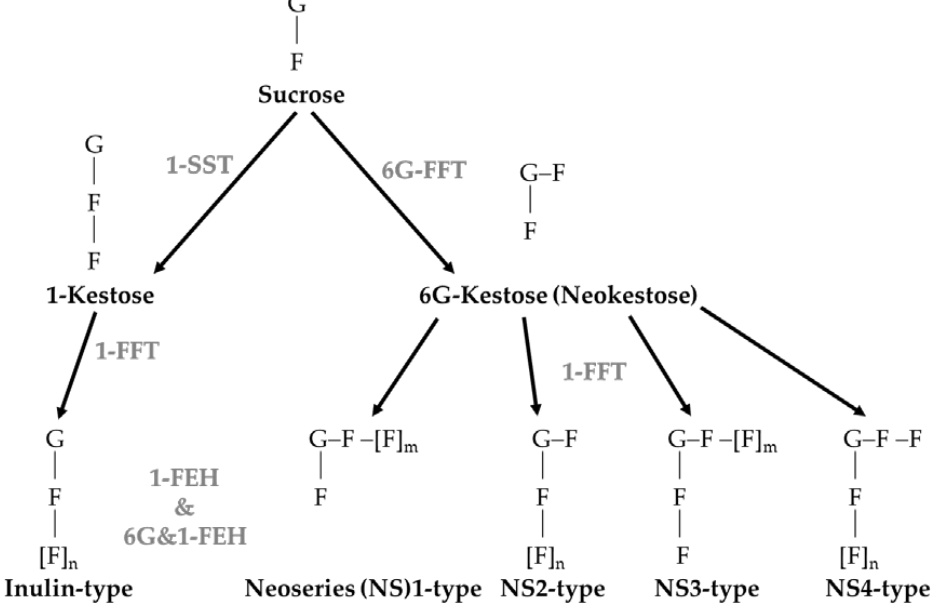
Figure 1. Oligosaccharide distribution patterns obtained by MALDI-MSI. Shown is a light microscopic image of a section together with the extracted ion intensity plots of the molecular ions [M + K] + for sucrose ( m/z 381) with a degree of polymerization (DP) of 2, as well as for oligosaccharides with DP3 ( m/z 543), DP4 ( m/z 705), DP5 ( m/z 867), DP6 ( m/z 1029), DP7 ( m/z 1191), DP8 ( m/z 1353), DP9 ( m/z 1515), DP10 ( m/z 1677), and the polysaccharide with DP11 ( m/z 1839) for one representative experiment.